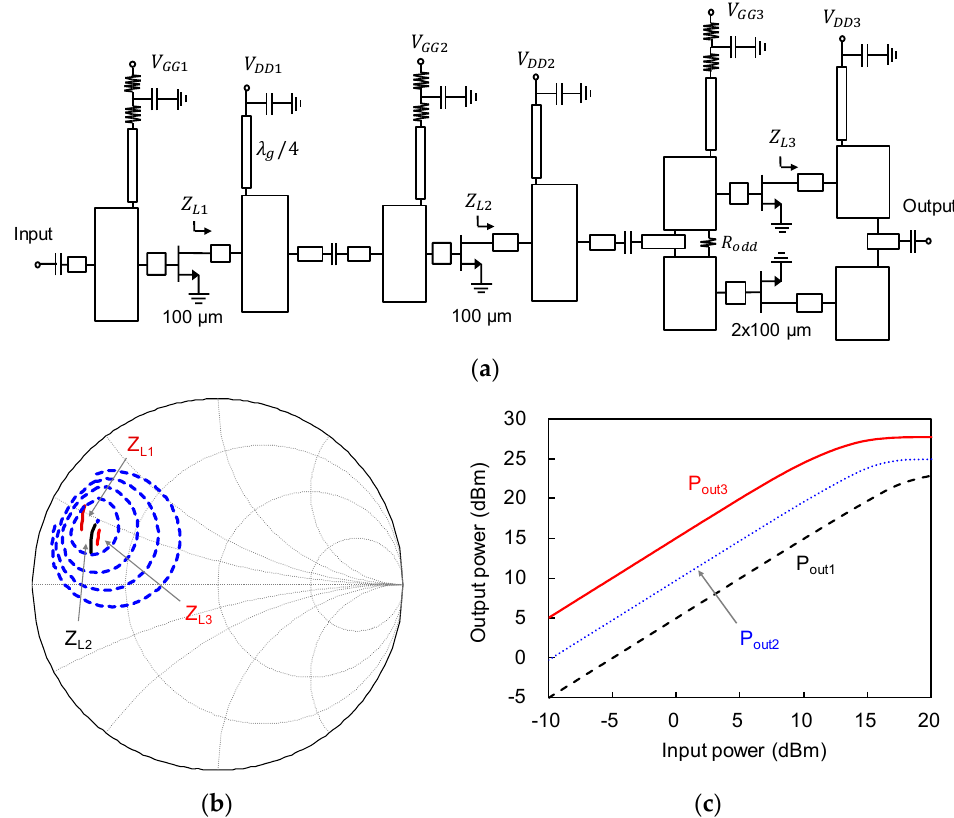
Figure 4. Design of three-stage power amplifier. ( a ) Circuit schematic. ( b ) Load impedance of each stage of designed amplifier (from 88 to 92 GHz) on top of load-pull contours at 90 GHz. ( c ) Simulated output power of each stage as a function of input power at 90 GHz.